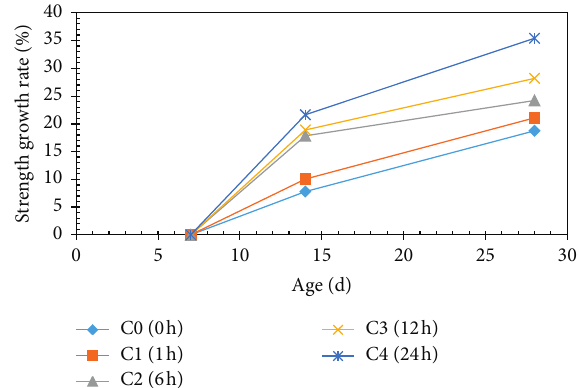
Figure 8: Strength growth rate for the concrete at different ages.